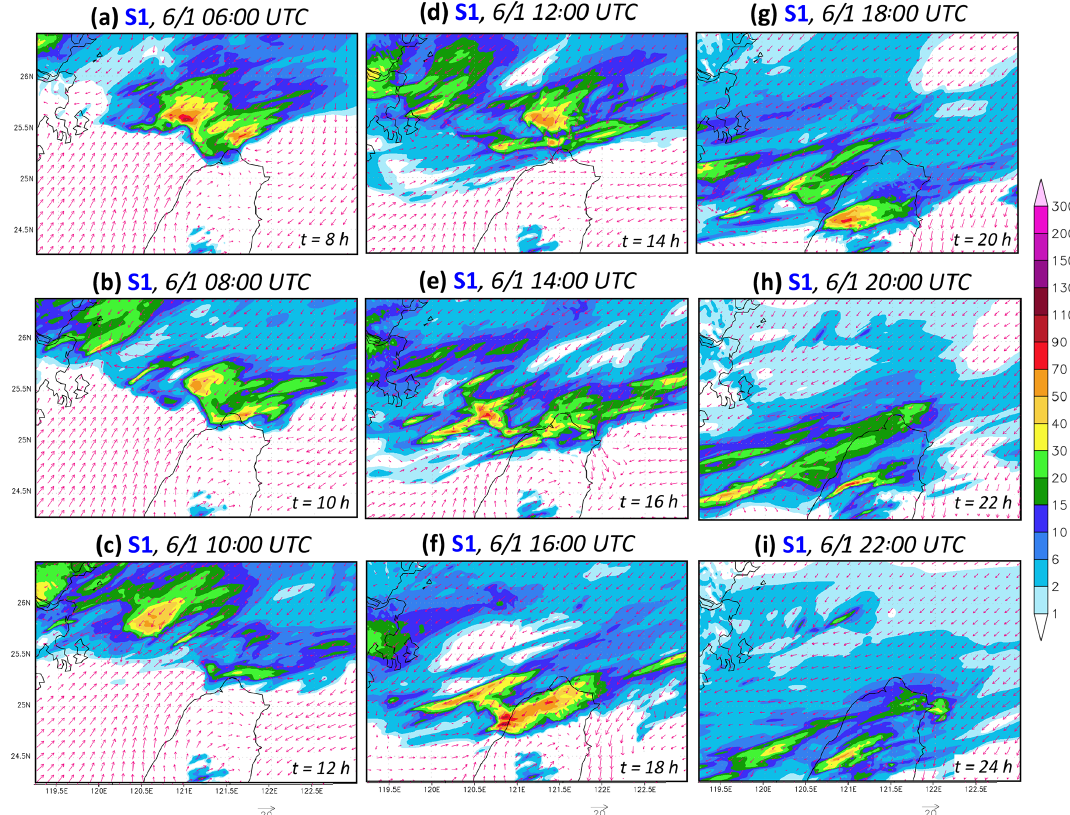
Figure 11. Model surface winds at 10m height (ms − 1 , reference vector at bottom) and hourly rainfall (mm, color) near northern Taiwan every 2h from (a) 06:00 to (i) 22:00UTC on 1 June 2017 in the S1